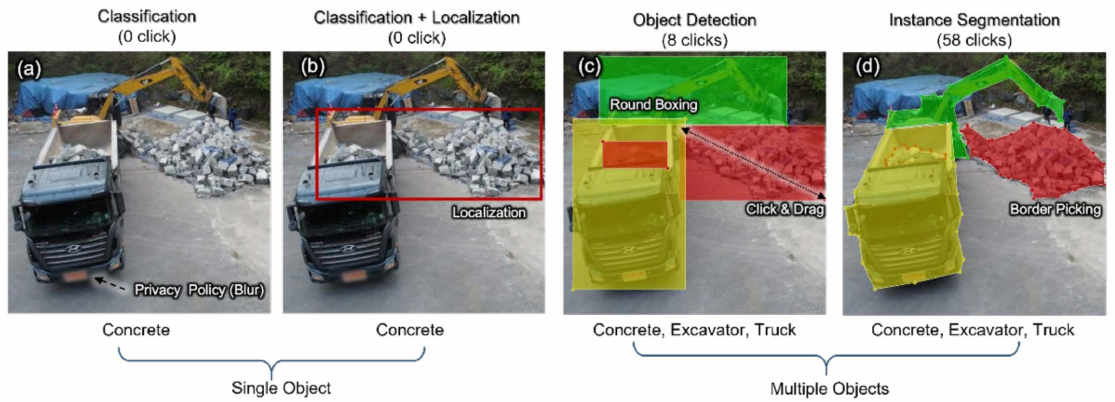
Figure 4. ( a ) Classification (0 click); ( b ) Classification + Localization (0 click); ( c ) Object Detection (8 clicks); ( d ) Instance Segmentation (58 clicks). A typical artificial intelligence method to perceive images. The number in the parentheses represents the number of mouse clicks. License plates and human faces were mosaicked or blurred for privacy. Following the development of the ability to perceive various objects on one image, the number of mouse clicks as well as the refinement time increased, whereas the volume of the training dataset decreased, leading to quickened learning speed and, thus, the need for comparative studies on this